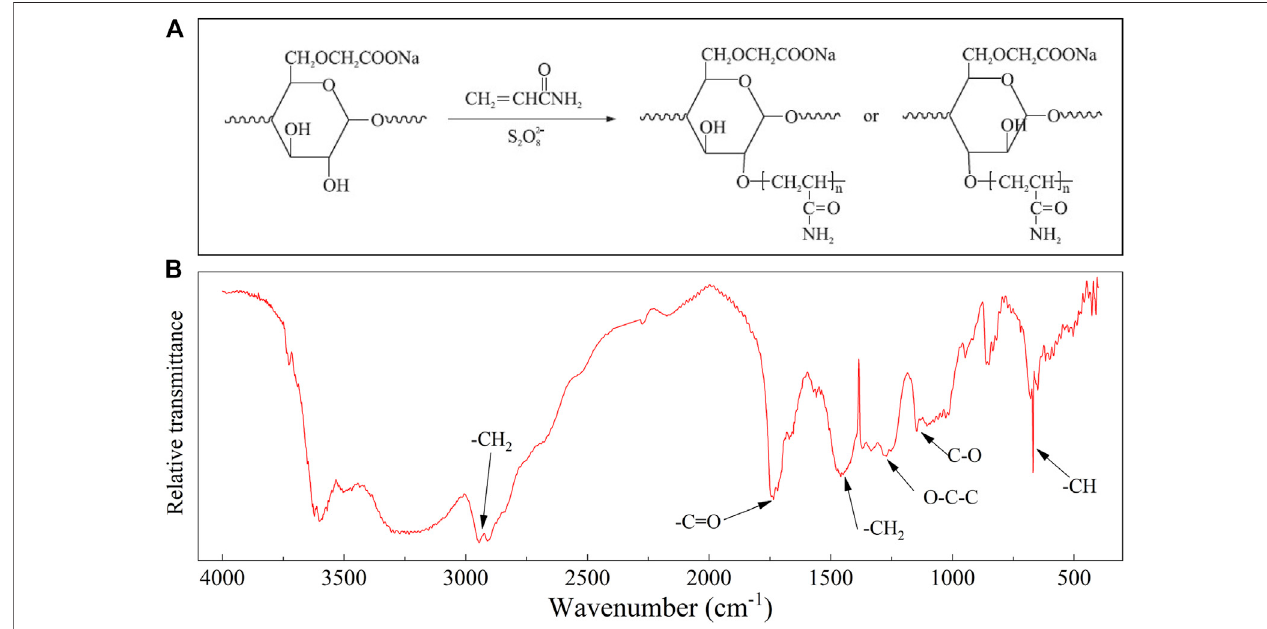
FIGURE 3 | (A) Reaction formula for preparing cross-linked polymers (CLPs); (B) Fourier-transform infrared re fl ection spectrogram of CLPs.